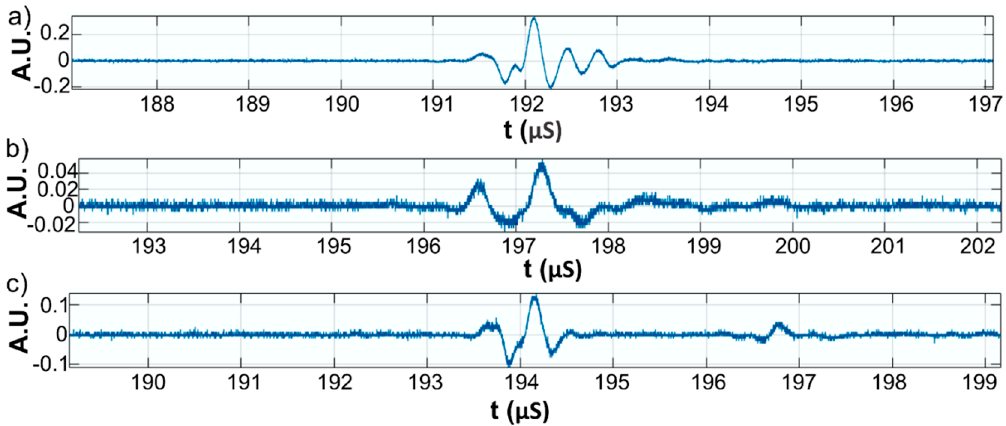
Figure 12. Zoomed third echo for: Wi ( a ); WZn ( b ); and Wd ( c ).